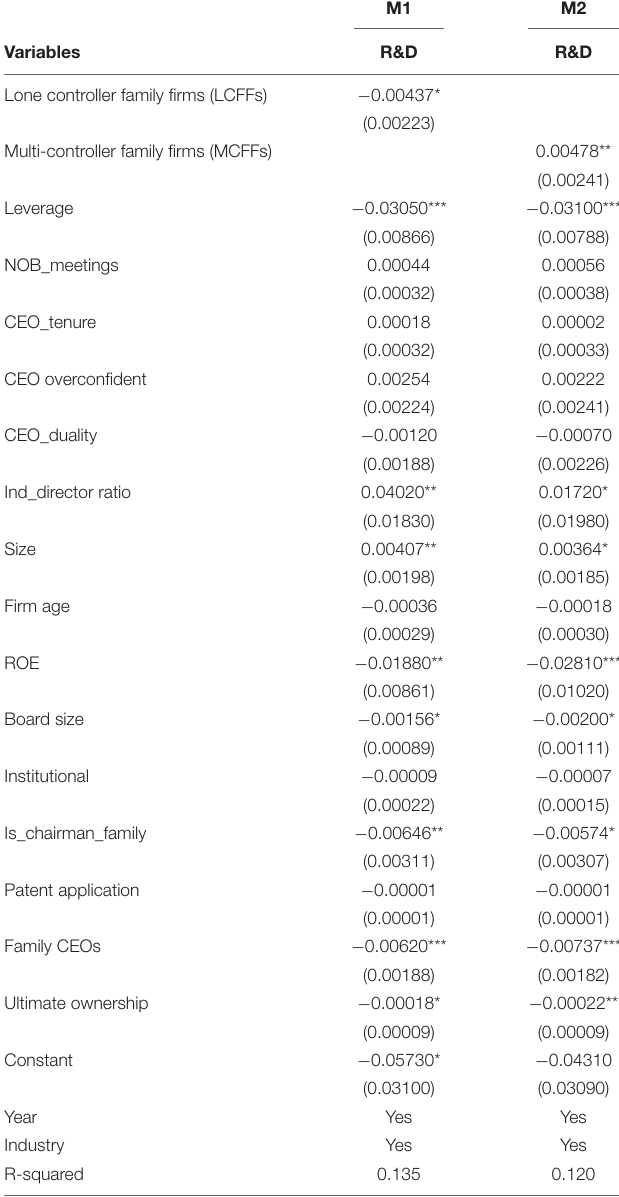
TABLE 5 | Regression results without